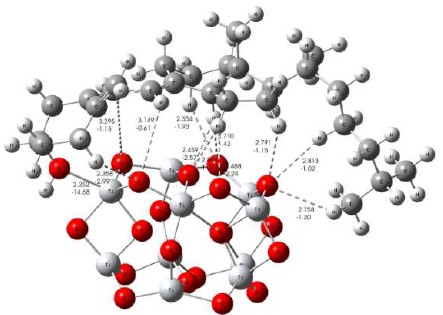
Figure 6. The most stable structure of the (TiO 2 ) 10 –cholecalciferol (vitamin D3) predicted by DFT; selected values of bond distances in Å and bond energies in kcal mol − 1 .